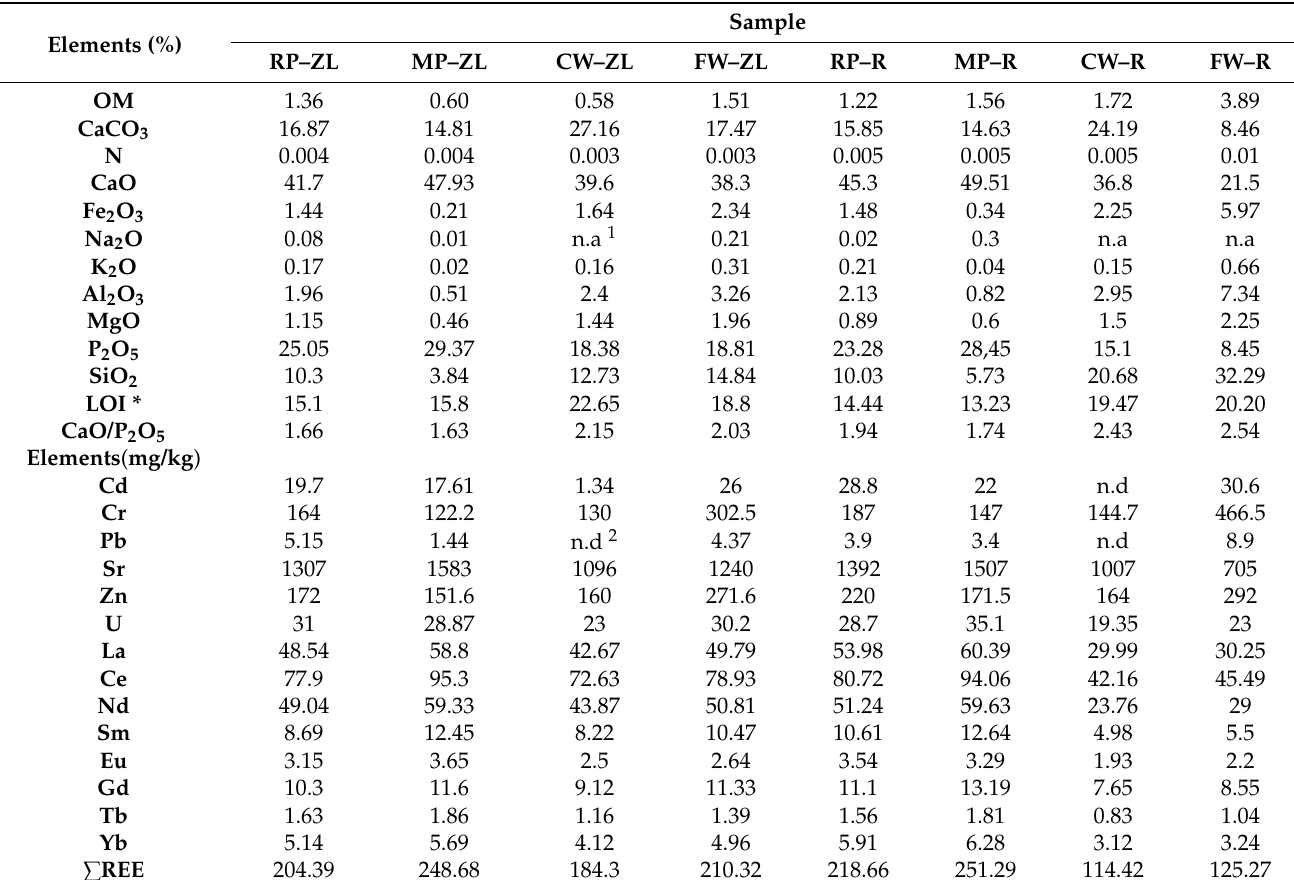
Table 3. Whole-rock chemical composition of the input and output products of M’Dhilla-Zone L (ZL) and Redeyef laundries (references of samples are as in Tables 1 and